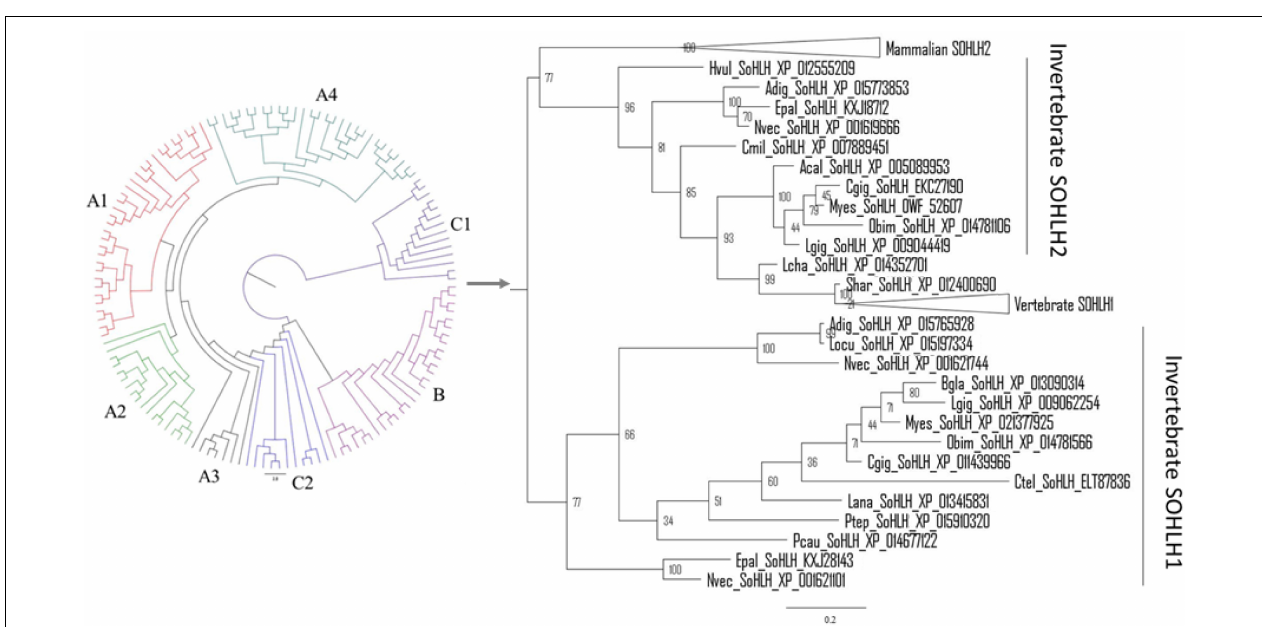
FIGURE 2 | Molecular phylogenetic analysis of SOHLH sequences. The phylogenetic analysis was constructed based on the bHLH domain of SOHLH by MrBayes. A1, mammalian SOHLH1; A2, aves SOHLH1; A3, reptilian SOHLH1; A4, fish SOHLH1; B, mammalian SOHLH2; C1, invertebrate SOHLH1; C2, invertebrate SOHLH2. The same tree with branch lengths, support values and gene names, is shown in Supplementary Figures S3 , S4